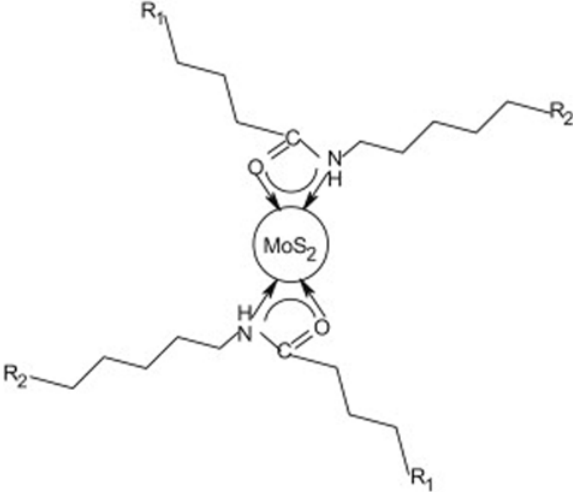
Figure 5. Structure model of the surface modified MoS reference [76] with permission from Elsevier.